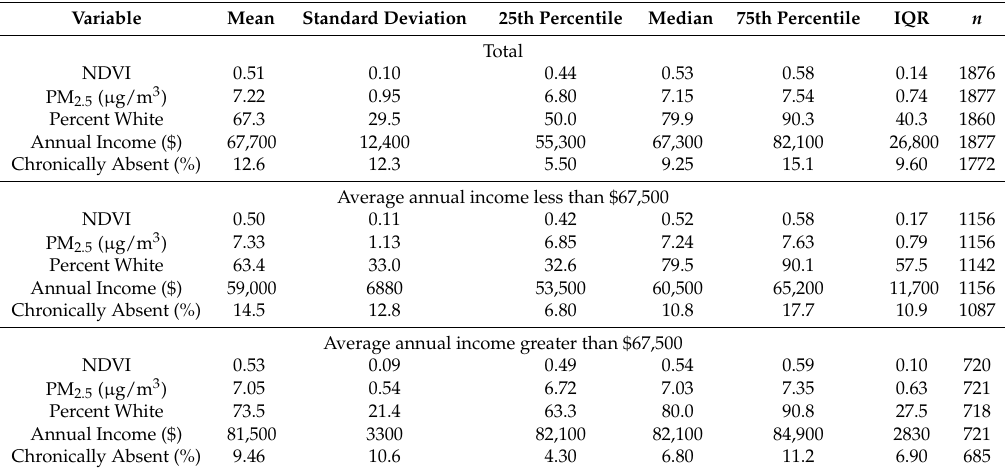
Table 1. Descriptive statistics of exposures and outcomes, stratified by average annual income in each school’s county.